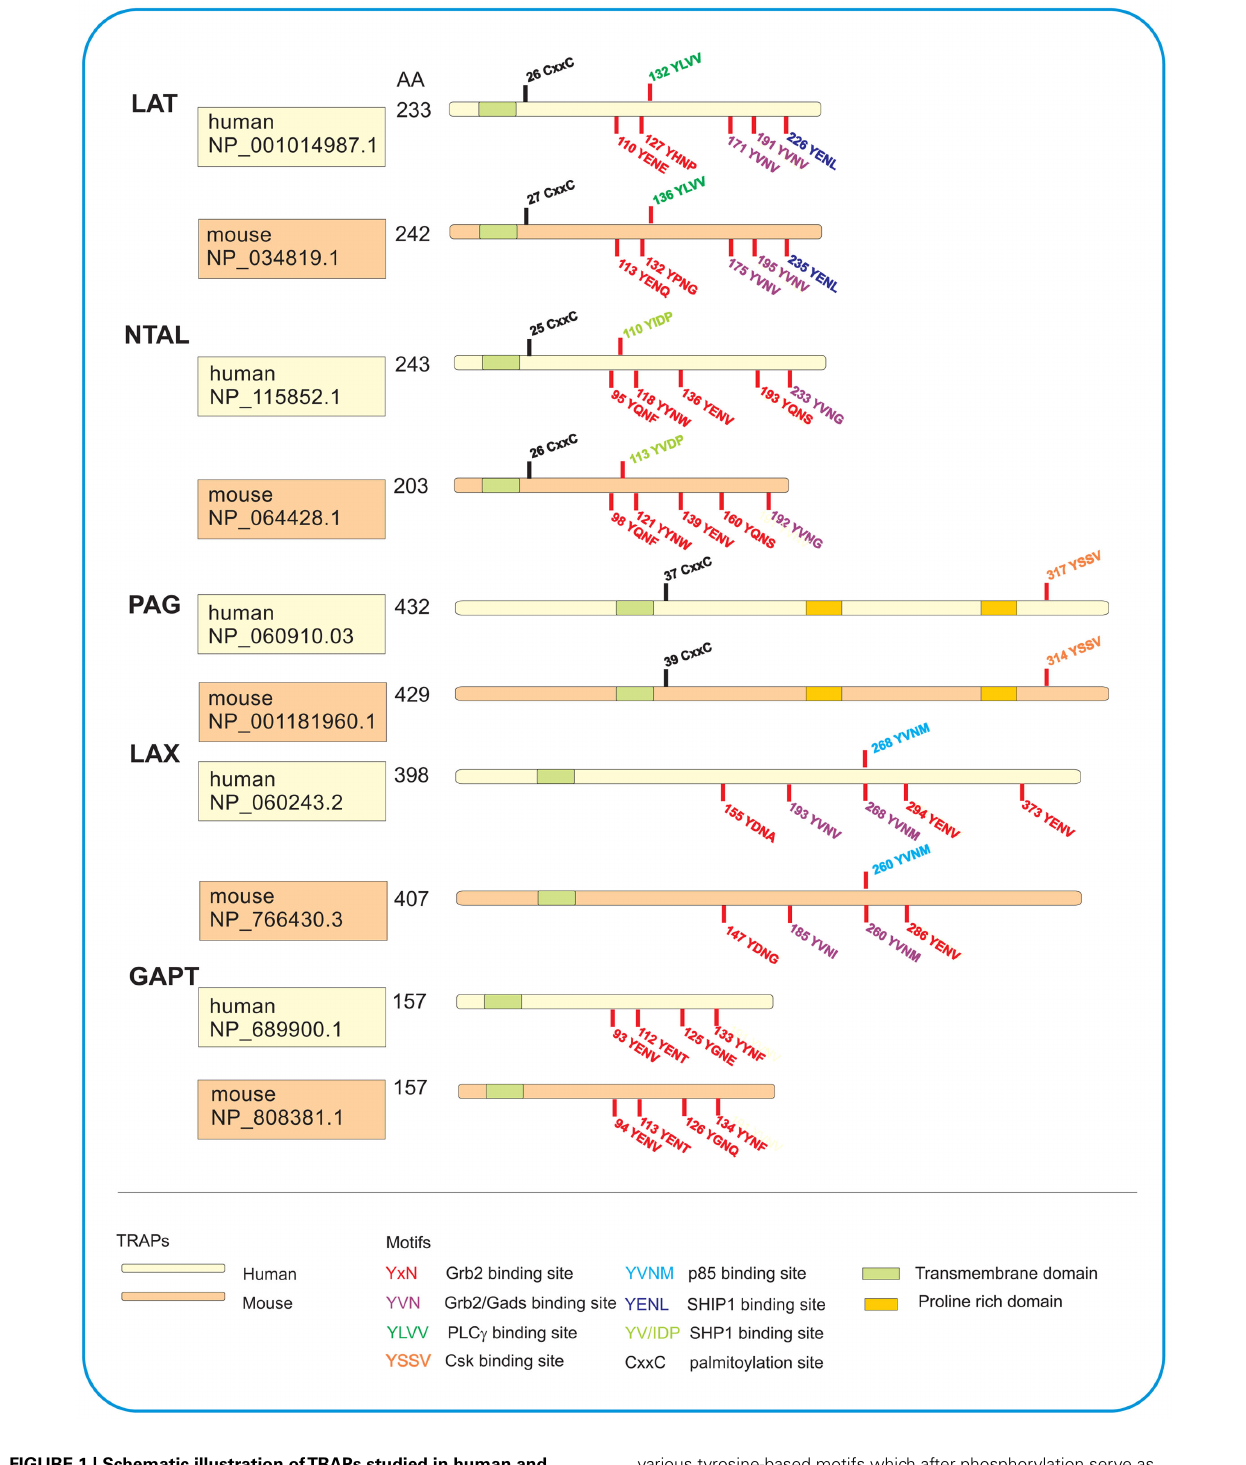
various tyrosine-based motifs which after phosphorylation serve as binding sites for the indicated SH2-containing proteins. PAG also contains proline-rich domains serving as anchor for SH3-containing proteins. Number of amino acids (AA) in eachTRAP as well as accession numbers in the GenBank sequence database provided by National Center for Biotechnology Information (NCBI) are also